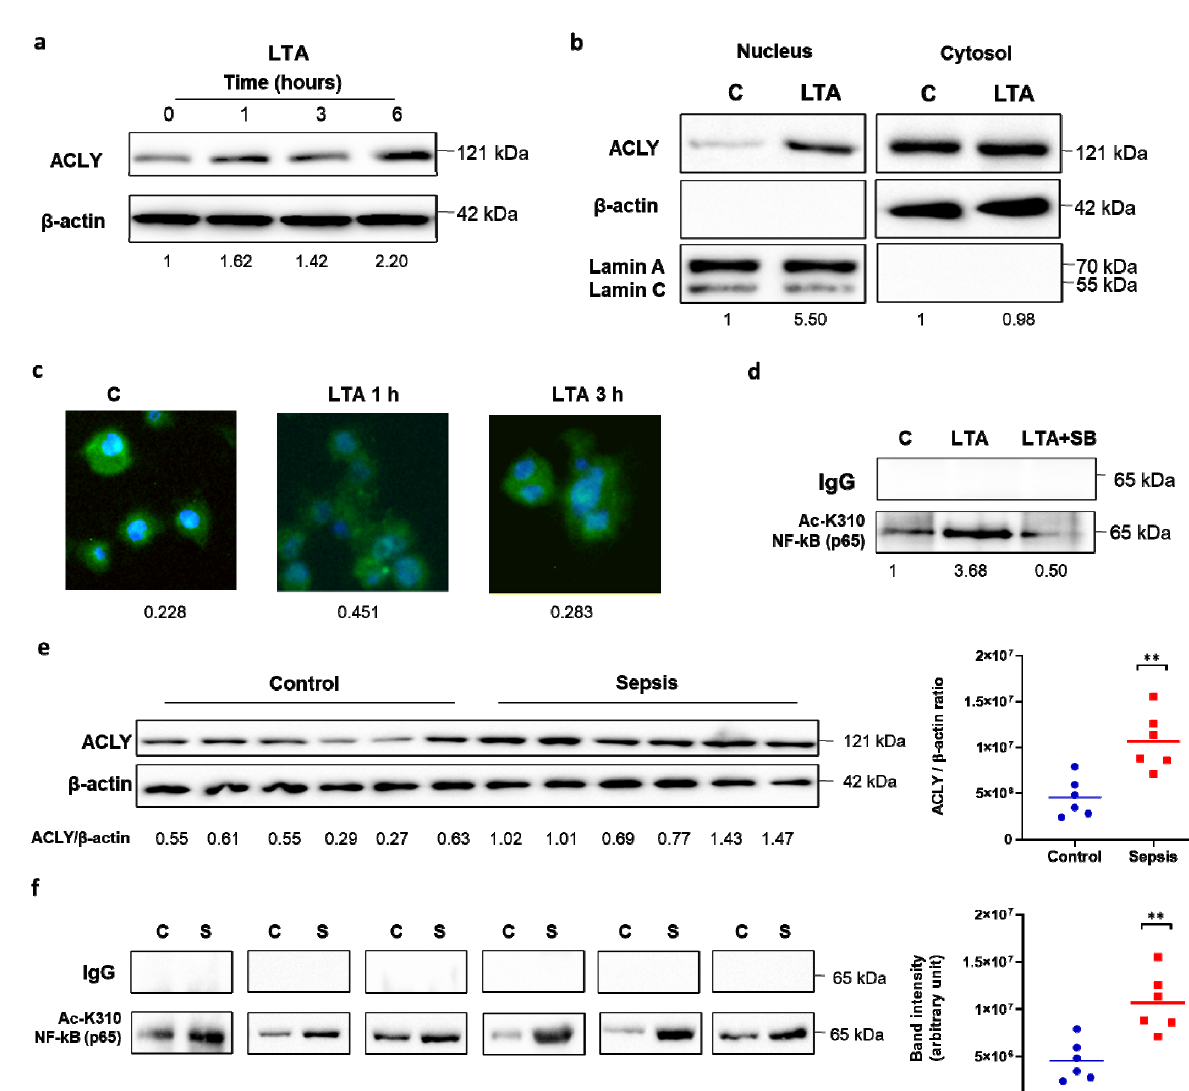
Figure 4. LTA and sepsis in the early hyperinflammatory phase triggered ACLY-mediated NF- κ B acetylation. Human PBMC-derived macrophages were triggered by LTA, and ( a ) western blot experiments were performed to evaluate ACLY protein. ( b ) Nuclei were isolated by cell fractionation. In nuclear and cytoplasm fractions, ACLY, β -actin, and lamin proteins were detected by specific antibodies. ( c ) Time course of ACLY nuclear translocation by immunocytochemistry (ICC) using anti-ACLY and DAPI nuclear staining in iBMDM cells treated with LTA. ( d ) In human PBMC-derived macrophages triggered by LTA, with or without SB, NF- κ B (p65) was immunoprecipitated with a specific antibody and then analyzed by western blotting with an anti-NF- κ B p65 (acetyl K310) antibody. ( e , f ) Macrophages differentiated from PBMCs of patients with sepsis in the early hyperinflammatory phase and age-matched healthy controls were used to quantify ACLY protein by western blot experiments ( e ) and to immunoprecipitate NF- κ B (p65) with a specific antibody and then to analyze by western blotting with an anti-NF- κ B p65 (acetyl K310) antibody. ( f ) Western blotting data presented are representative of at least 3 independent experiments. In ( a , b , e ), protein levels are quantified against β -actin. In ( a , b , d ), the mean of the protein values was normalized versus the mean of the proteins in untreated cells (C), and the results are reported under each image. In ( c ), quantitation of ACLY in ICC experiments was normalized to the DAPI nuclear stain. In ( e , f ), statistical significance of the differences between the ACLY amount in the controls and sepsis samples evaluated by using a Mann–Whitney U test (** p < 0.01) is depicted in dot plots (right panels).